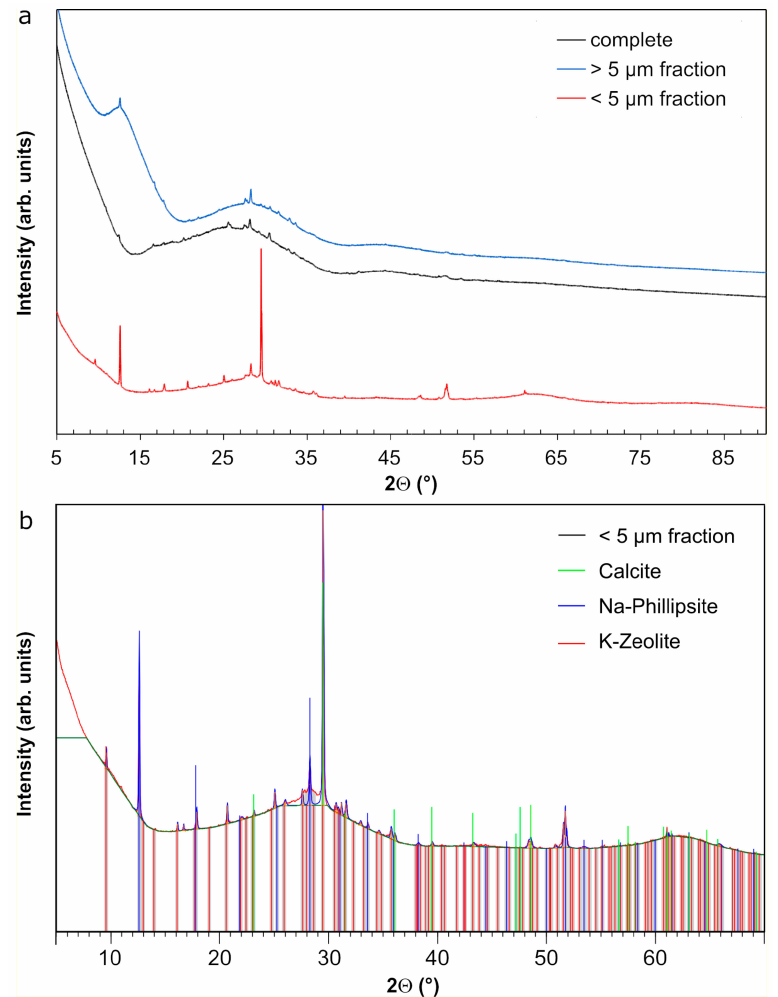
Figure 5. ( a ) XRD patterns of the complete glass powder altered for 385 days in YCWCa at 70 ◦ C, and of the grain size fractions <5 µ m and >5 µ m. ( b ) Zoomed in XRD pattern of the grain size fraction <5 µ m with the identified crystalline phases and their respective peak